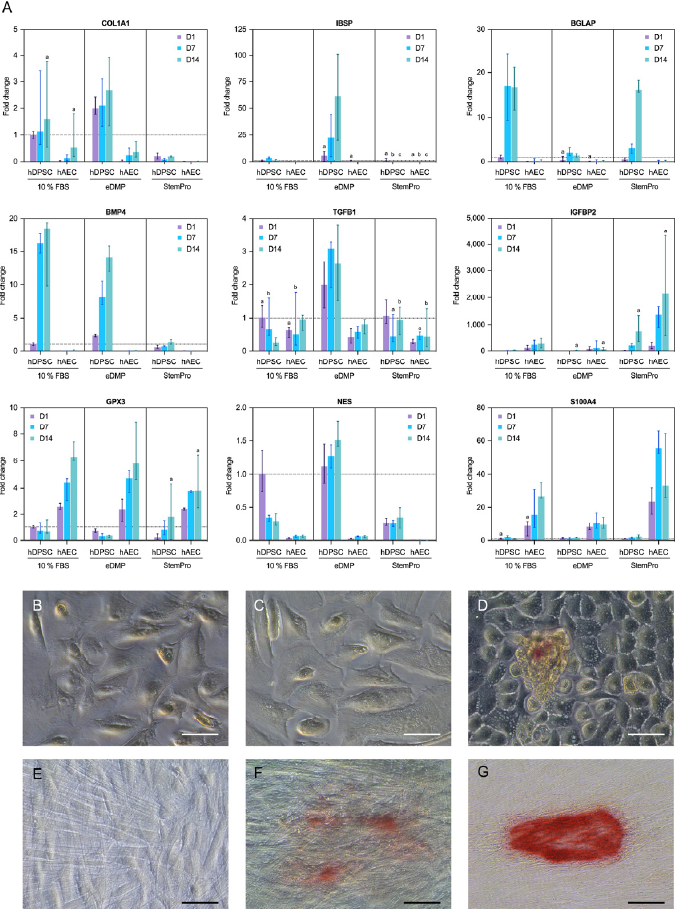
Figure 4. Expression of odontogenic and mineralization-associated genes. Effect of eDMPs and StemPro on expression of odontogenic and mineralization-associated marker genes ( COL1A1, BMP4, IBSP, IGFBP-2, NES, TGFB1 and BGLAP ) in hAECs and hDPSCs at days 1, 7 and 14 ( A ). Genes indicative of epithelial–mesenchymal transition ( S100A4 ) and protection against oxidative damage ( GPX3 ) are also depicted ( A ). Target gene expressions are depicted relative to the untreated control (hDPSCs with 10% FBS at day 1) and median values were calculated from two independent experiments in duplicated samples ( n = 4). Non-significant differences between hAECs and hDPSCs for each medium and follow-up point are marked with lowercase letters (a, b, c). The effect of eDMPs and StemPro on mineralization of hAECs ( B – D ) and hDPSCs ( E – G ) using Alizarin Red staining assay. Calcium deposits were evident in hAECs cultured with StemPro ( D ) and hDPCS cultured with eDMPs ( F ) and StemPro ( G ). (Scale bars: 50 µm.)